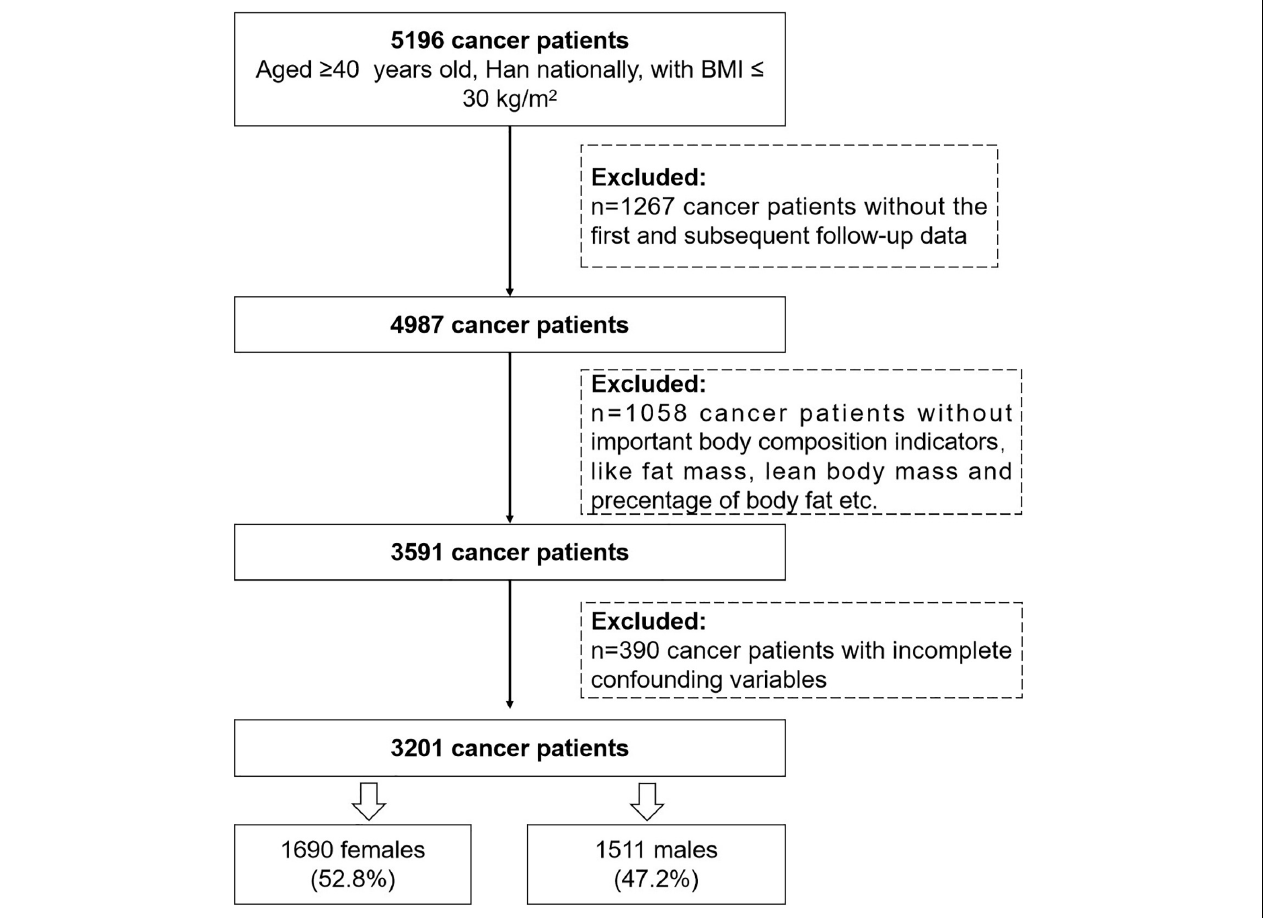
FIGURE 1 | Flowchart for the study